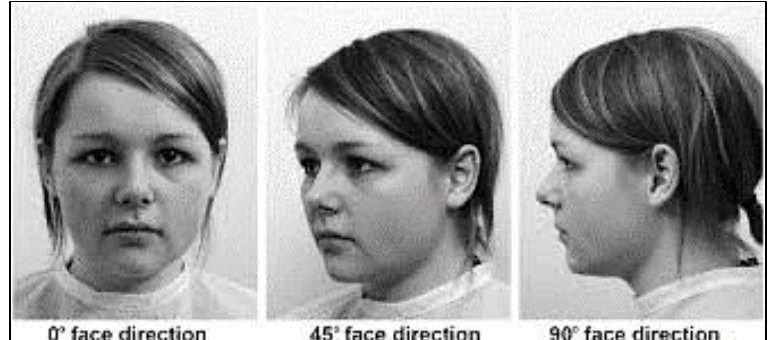
Figure 7. Different directions of